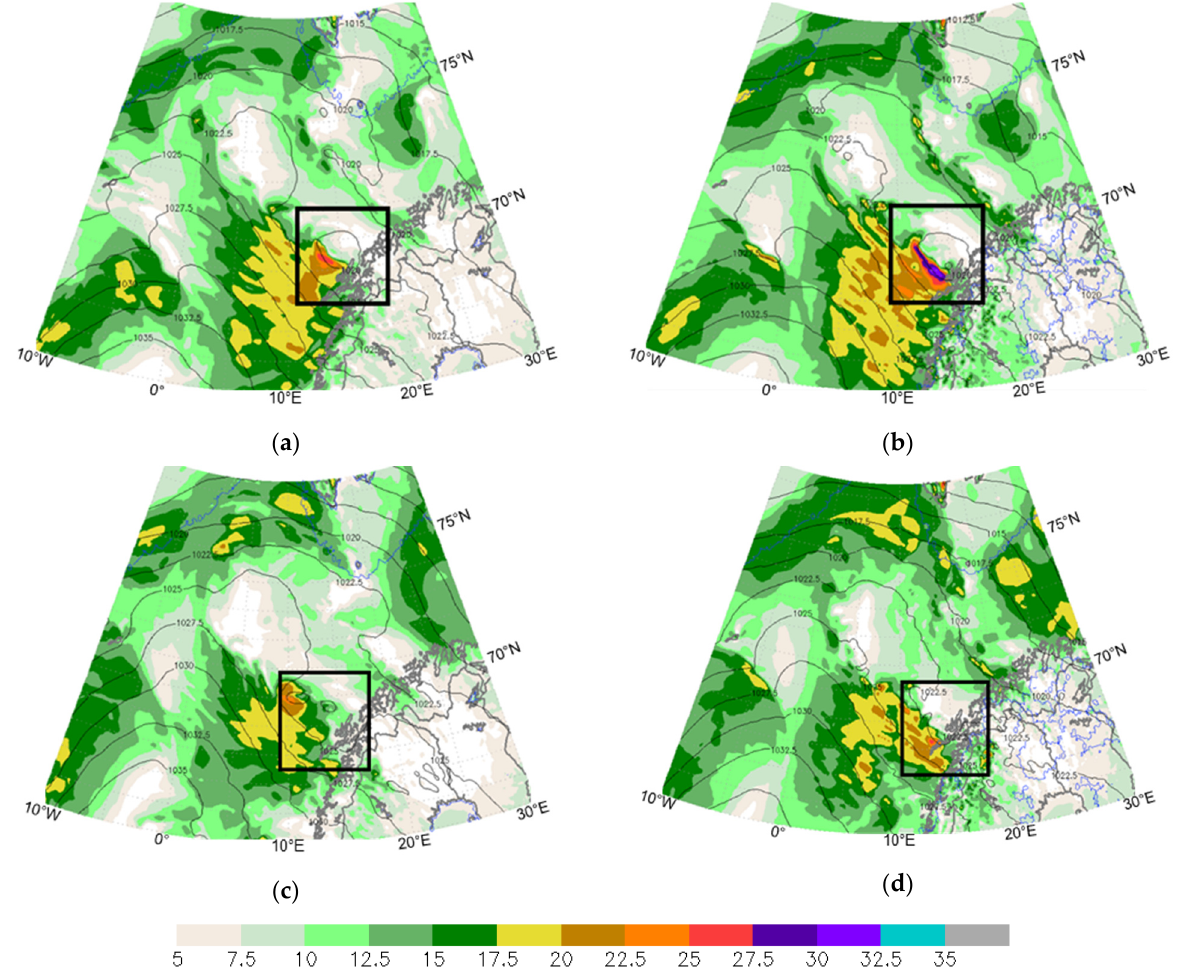
Figure 6. COSMO-CLM-A6.6 (left) and ICON-A6.5 (right) comparison for different lead times: wind gusts and sea-level pressure. Base times: 00:00 UTC 20 March 2020 with a lead time of 12 h ( a , b ) and 00:00 UTC 19 March 2020 with a lead time of 36 h ( c , d ). Valid time: 12:00 UTC 20 March 2020. Black square shows the position of the polar low (PL) according to the satellite image.